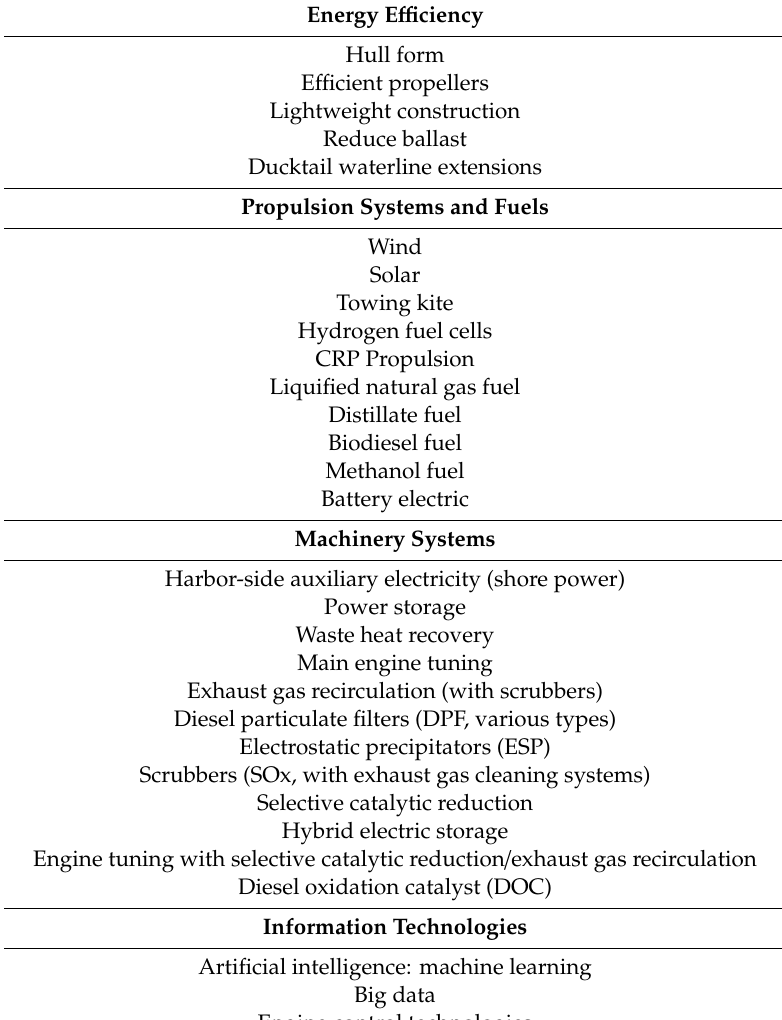
Table 7. Illustrative Technologies and Operations that Have Been Proposed by Various Sources for Reducing Shipping’s